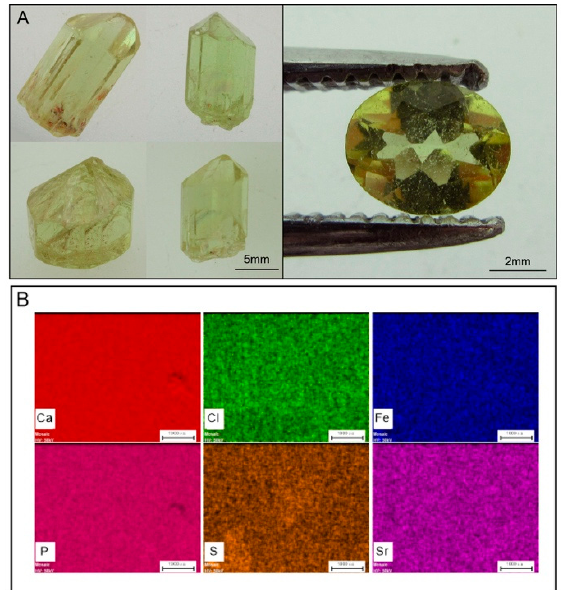
Figure 5. Durango apatites and elemental maps obtained by micro-XRF mapping: ( A ) The gem-like Durango apatite crystals; ( B ) the distribution of Ca, Cl, Fe, P, S and Sr is shown.